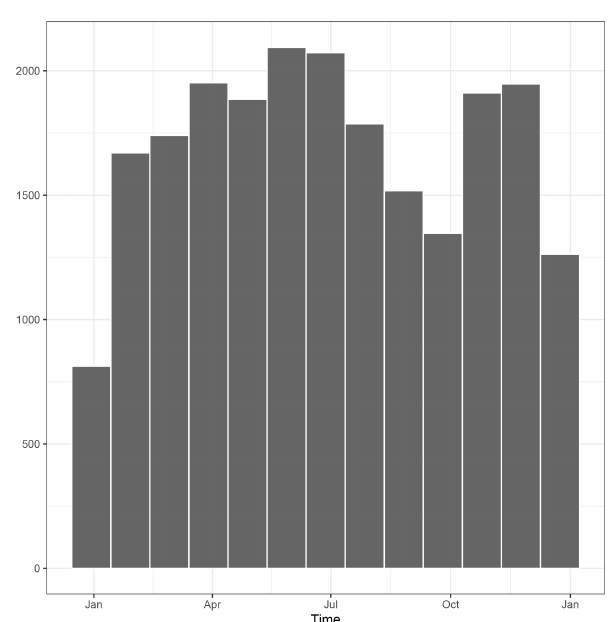
Table 1. Observation type and subcategories used in the Shirley Plantation document. Accounting Agriculture Human Labor Livestock Operations Weather selling experimenting health carpentry fattening burning hydrology harvesting holiday constructing feeding clearing precipitation pest problem delivering fixing dragging problem phenology runaway general health drying smokey problem hauling managing fallowing temperature replanting preserving moving ginning thundering sowing repairing problem hoeing wind conditions thinning traveling shearing hydrology weeding landscaping penning plowing problem shelling treating